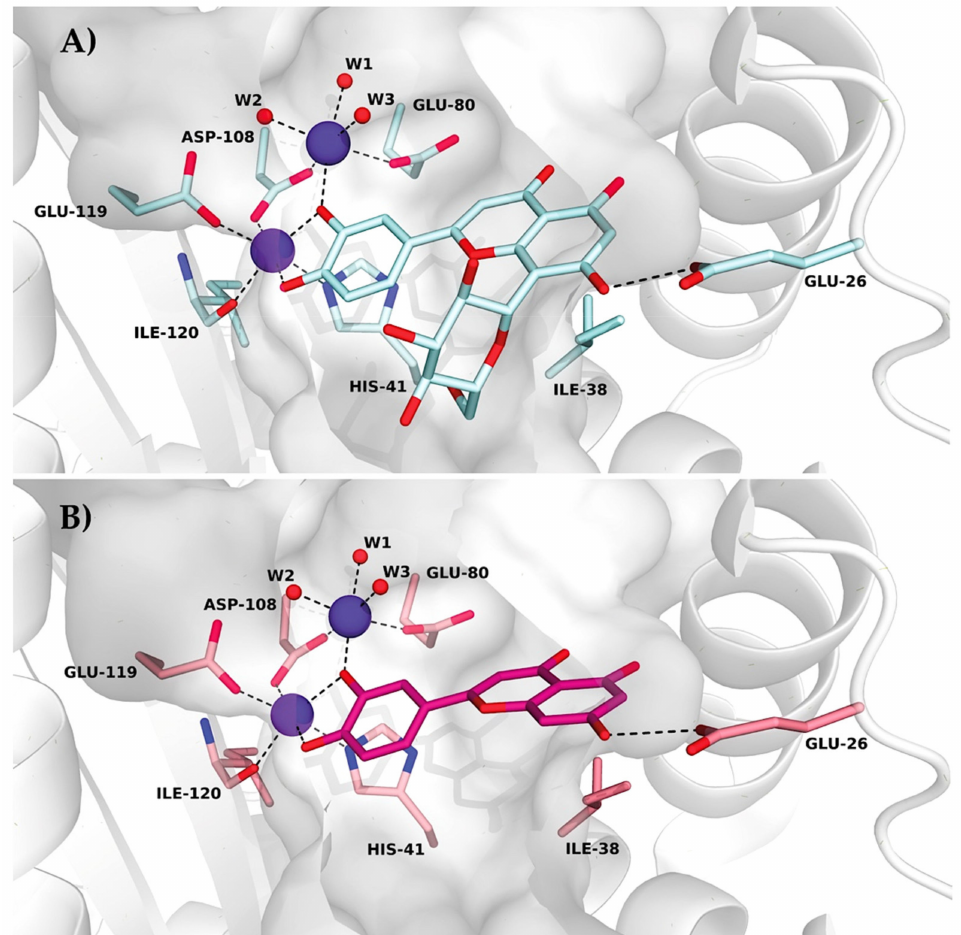
Figure 3. Comparison of crystal structures of PA-Nter in complex with orientin ( A ; PDB ID 7NUG) and luteolin ( B ; PDB ID 6YA5). The active site pocket containing two metal ions (purple-blue spheres) is presented as a grey surface. Interacting residues and ligands are in stick representation. Hydrogen bonds are shown as black dashes. Coordinating water molecules (W1, W2 and W3) are presented as red